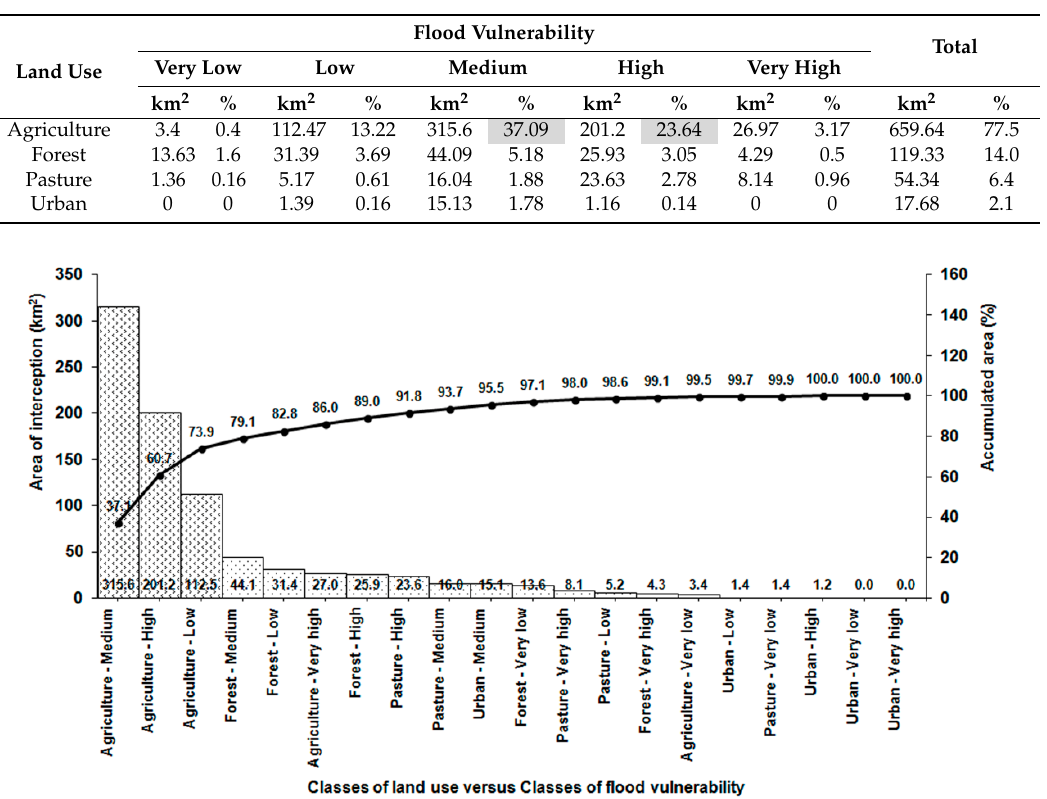
Table 7. Cross-classification of land use and flood vulnerability in the municipality of Batatais SP. The grey shaded cells represent concern situations because they correspond to medium and high flood vulnerability over large agricultural areas.